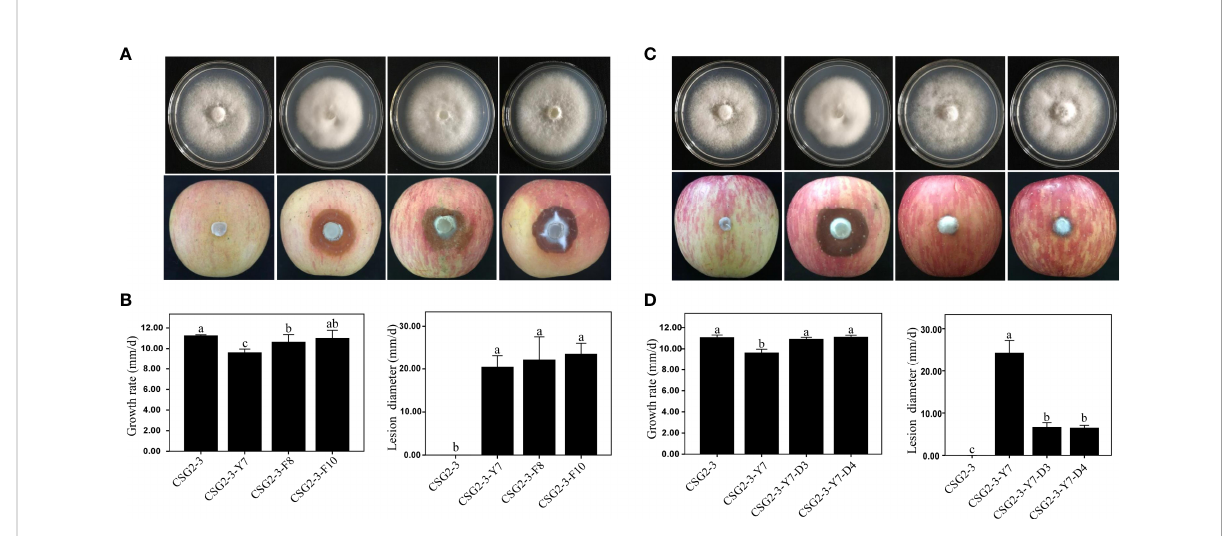
FIGURE 4 Growth rate and pathogenicity of the isogenic C. fructicola strain. (A, C) Colony morphology (up) and pathogenic situation on apples (down) of CSG2-3, CSG2-3-Y7, CSG2-3-F8/F10, and CSG2-3-Y7-D3/D4. (B, D) Growth rate (left) and pathogenicity (right) of CSG2-3, CSG2-3-Y7, CSG2- 3-F8/F10 and CSG2-3-Y7-D3/D4. The different letters on the bars indicate signi fi cant differences at the a =0.05 level of con fi dence according to one-way analysis of variance